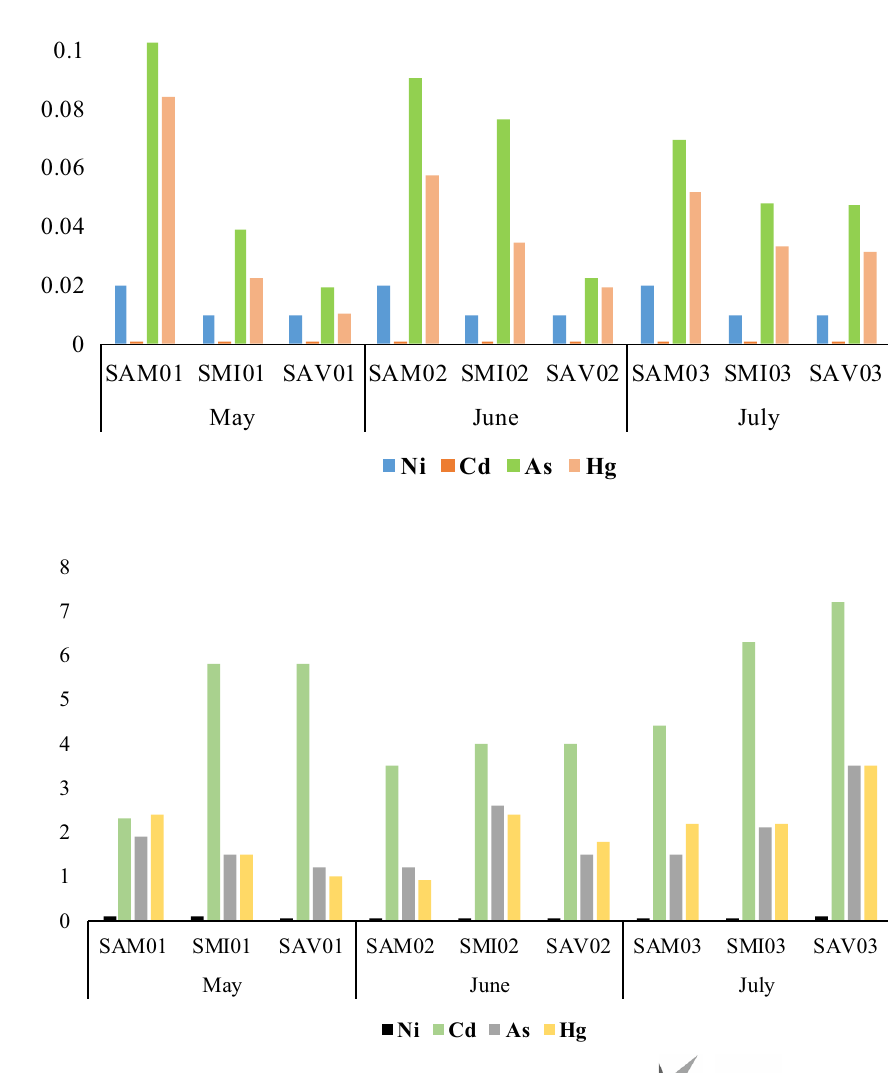
Fig. 10 Geo-accumulation index. SAM Usptream sample; SMI Sample collected in the middle of the mining site; SAV Downstream